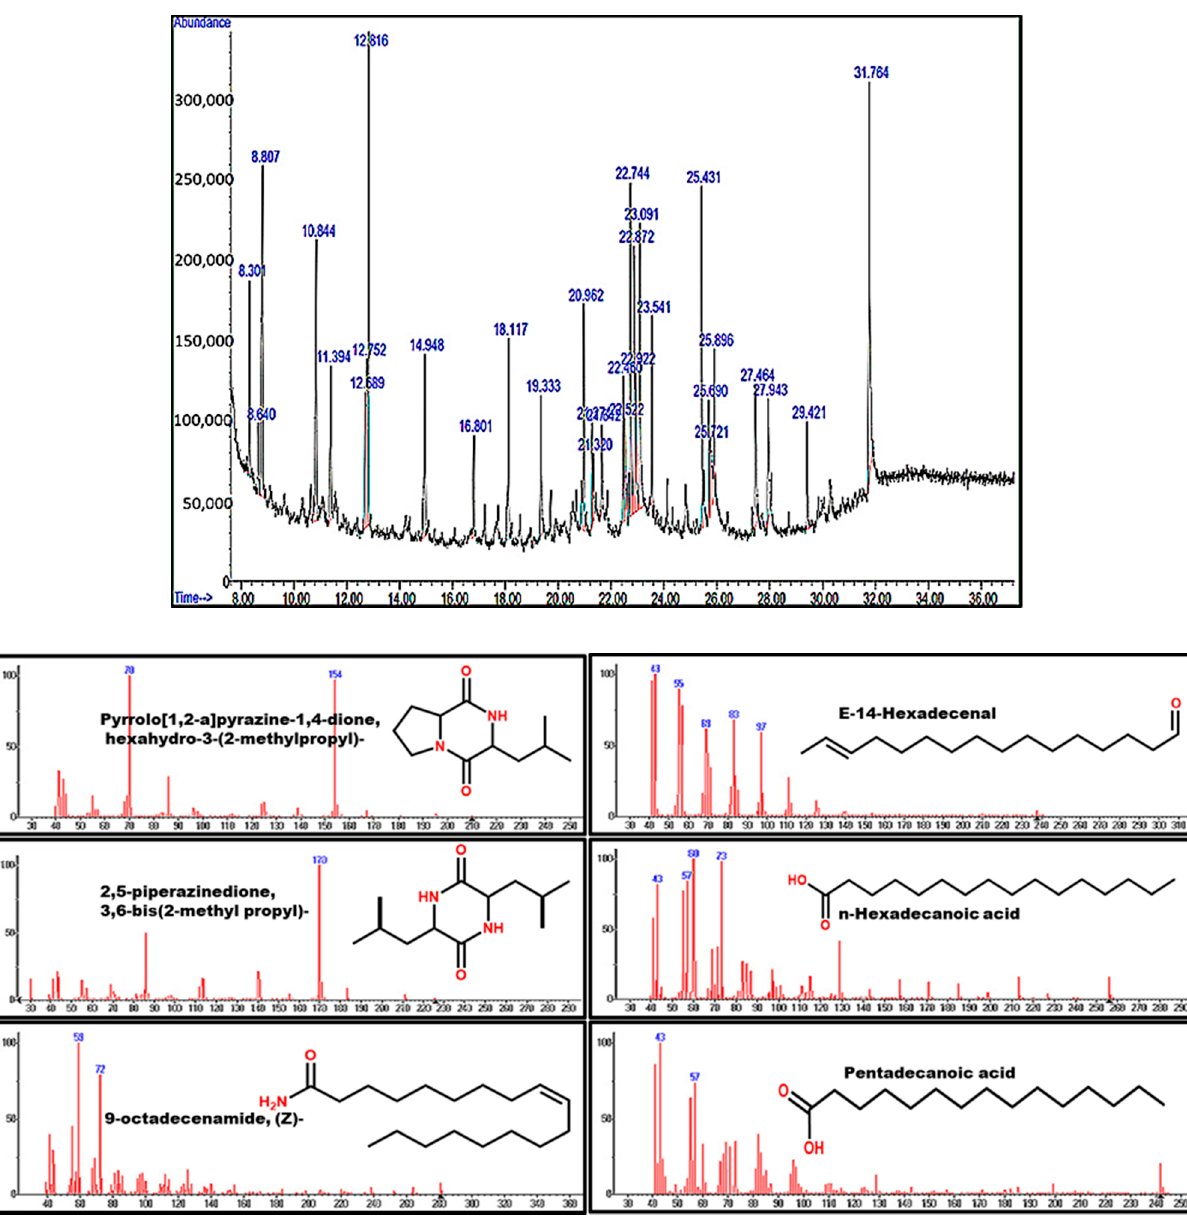
Figure 2. GC-MS chromatogram for ethyl acetate extract of P. oxalicum LA-1. Table 1. GC-MS analysis for methanolic fungal extract.